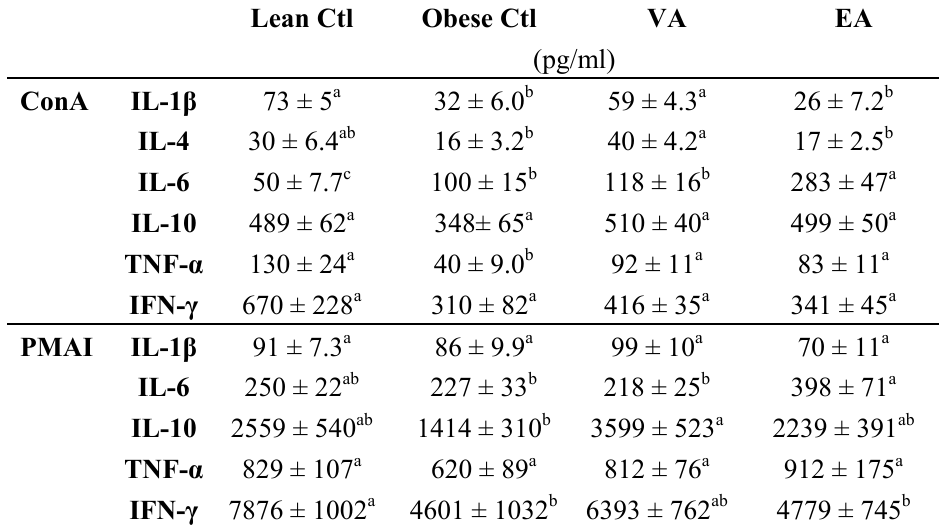
Table 5. Mitogen-stimulated cytokine production of lean rats and obese JCR:LA- cp rats fed Ctl, VA or EA diet.